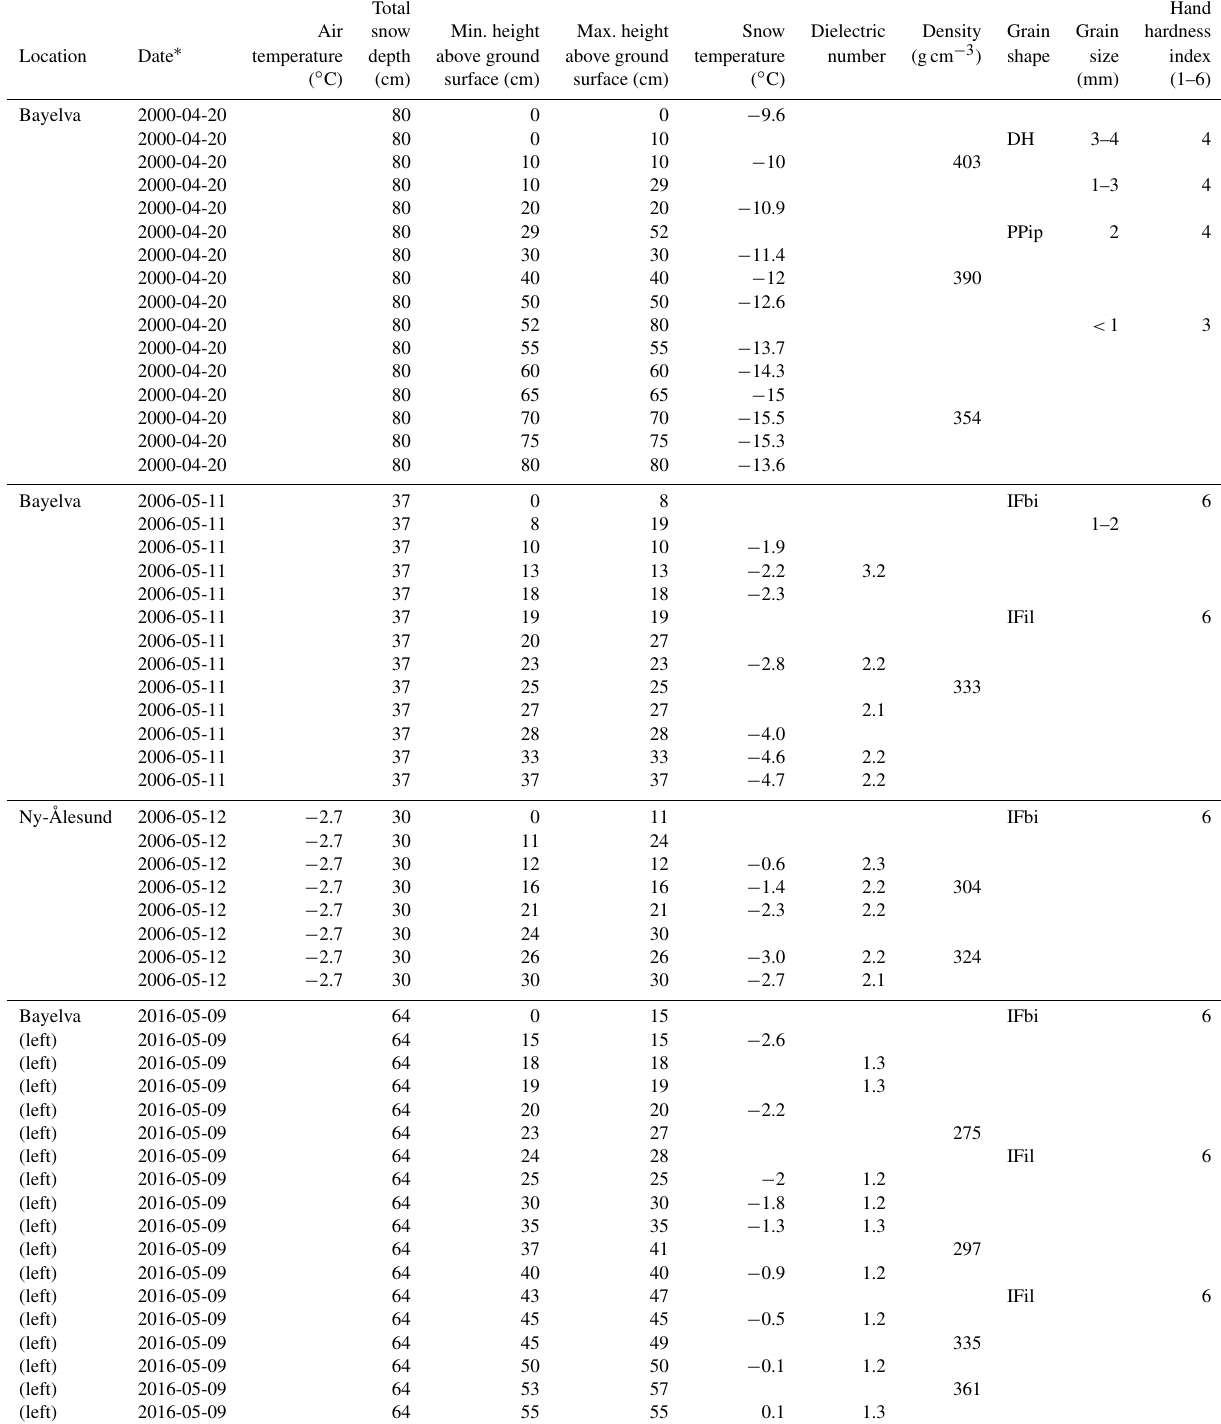
Table E1. Snow data obtained from manual probing of snow profiles in spring 2000 (Bayelva), 2006 (Bayelva and Ny-Ålesund) and 2016 (Bayelva). Data include stratigraphy, temperature, dielectric number, density and information on dominant grain shape, size and hand hard- ness index according to international snow classification (Fierz et al., 2009). Grain shape abbreviations are DH for depth hoar, IFbi for basal ice layer, IFil for horizontal ice layer and PPip for ice pellets. Hand hardness indices are 1 for very soft, 2 for soft, 3 for medium, 4 for hard, 5 for very hard and 6 for ice. Left and right refer to the measurement positions within the profile shown in Fig.